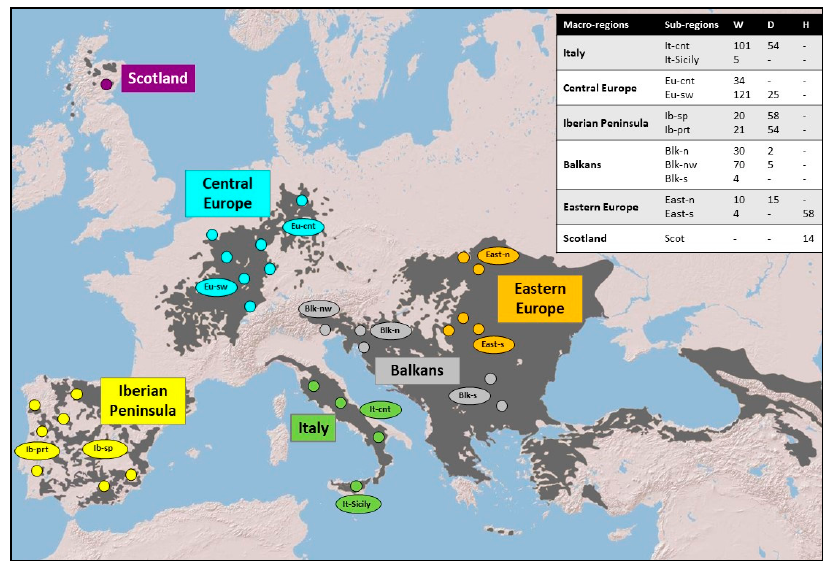
Figure 1. Map of the approximate cat sampling locations. Dark grey areas correspond to the most recently updated IUCN Felis silvestris distribution range [46]. Macro-regions (Italy, Central Europe, Iberian Peninsula, Balkans, Eastern Europe, Scotland) are indicated in different colors. Each macro-region was further subdivided into sub-regions (It-cnt: Central Italy; It-Sicily: Sicily; Eu-cnt: Center–North Germany; Eu-sw: Southern and Western regions of Central Europe; Ib-prt: Portugal; Ib-sp: Spain; Balk-n: Northern Balkans; Balk-s: Southern Balkans; Balk-nw Eastern Italian Alps and North-Western Dinarides; East-n: Poland; East-s: Hungary). Samples from the North-Eastern Italian Alps were included in the Balkans group (blk-nw) according to the most recent genetic structure detected in Europe through Bayesian assignment procedures performed using nuclear microsatellite genetic profiles [25]. Small circles indicate the approximate geographic locations within the main sampling areas. Each sub-region is provided with the number of analyzed samples classified on the base of their 31-STR assignment values [25]: W = wildcat; D = domestic cat; H = putative admixed. Further details are available in Supplementary Table